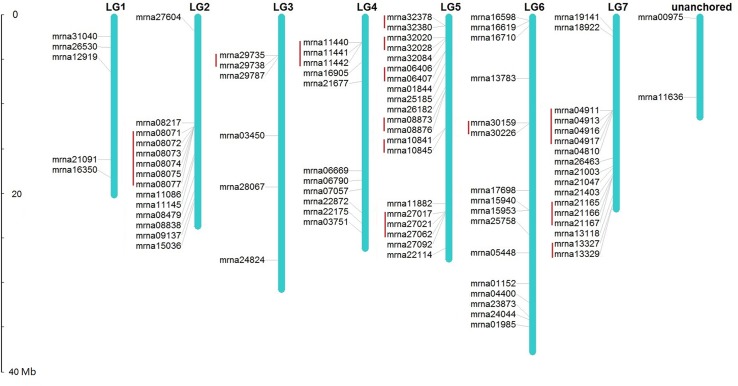
Locations of FveERF genes on the Fragaria vesca chromosomes. The size of a chromosome is indicated by its relative length. Tandemly duplicated genes are indicated with a red bar.